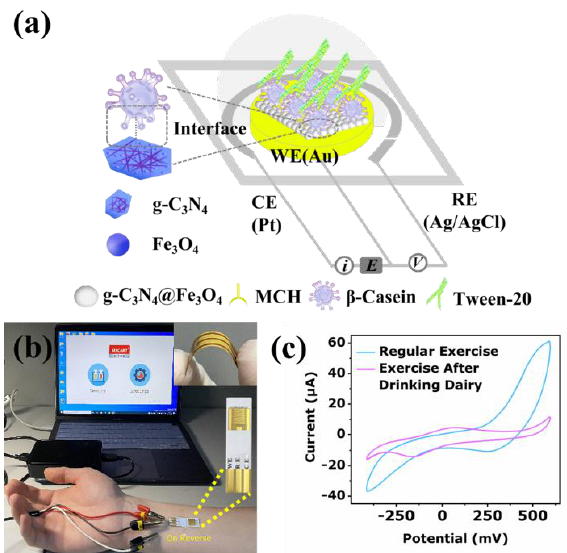
Figure 7. ( a ) Schematic diagram of wearable sweat sensor array, ( b ) Optical photo for real-time on- body sweat monitoring (Insert: Flexible sensing platform) and ( c ) Data-monitoring chart under dif- ferent exercise conditions.